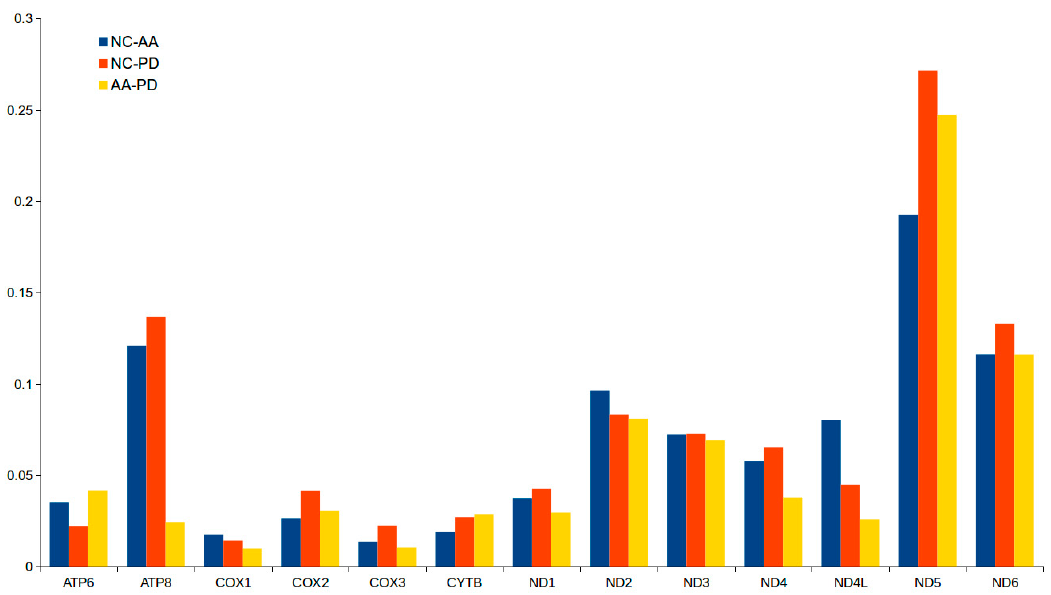
Figure 3. Evolutionary rates of the mitochondrial genome of A. amoyensis (AA), N. coibor (NC), and P. diacanthus (PD). The ratio means the rate of non-synonymous substitutions to the rate of synonymous substitutions (Ka/Ks) for each PCG.